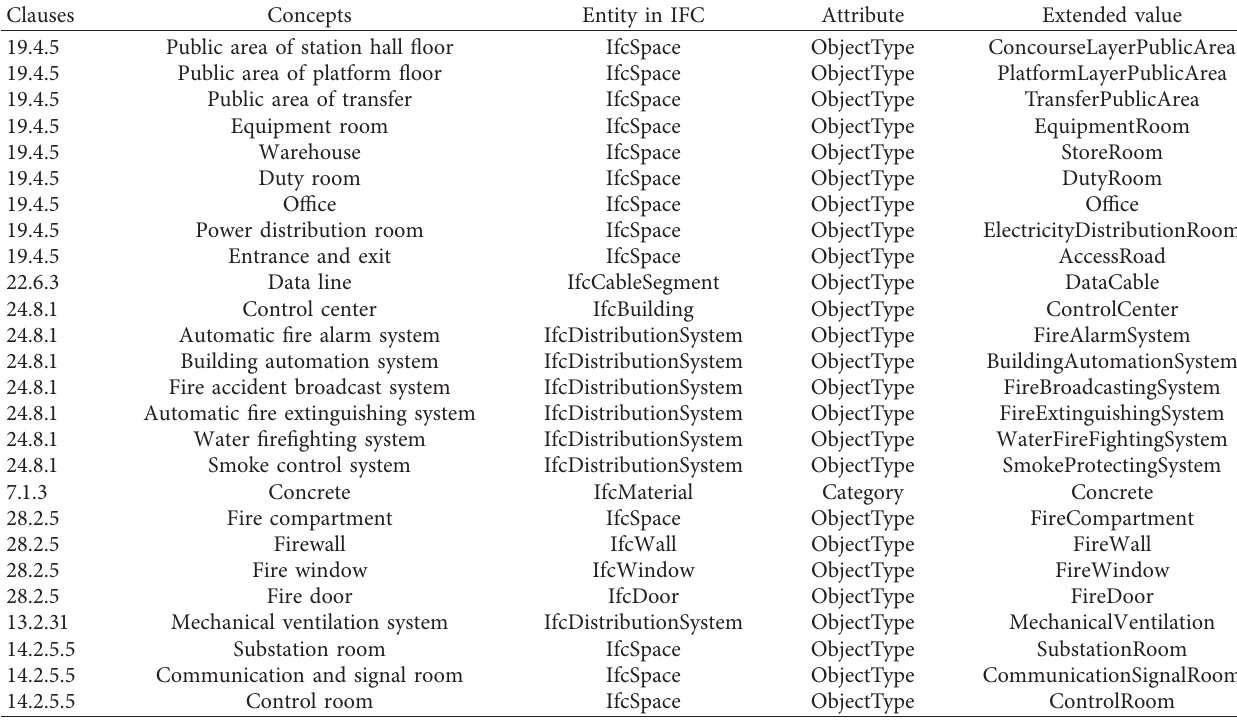
Table 4: Attribute value extension content mapping relationship.